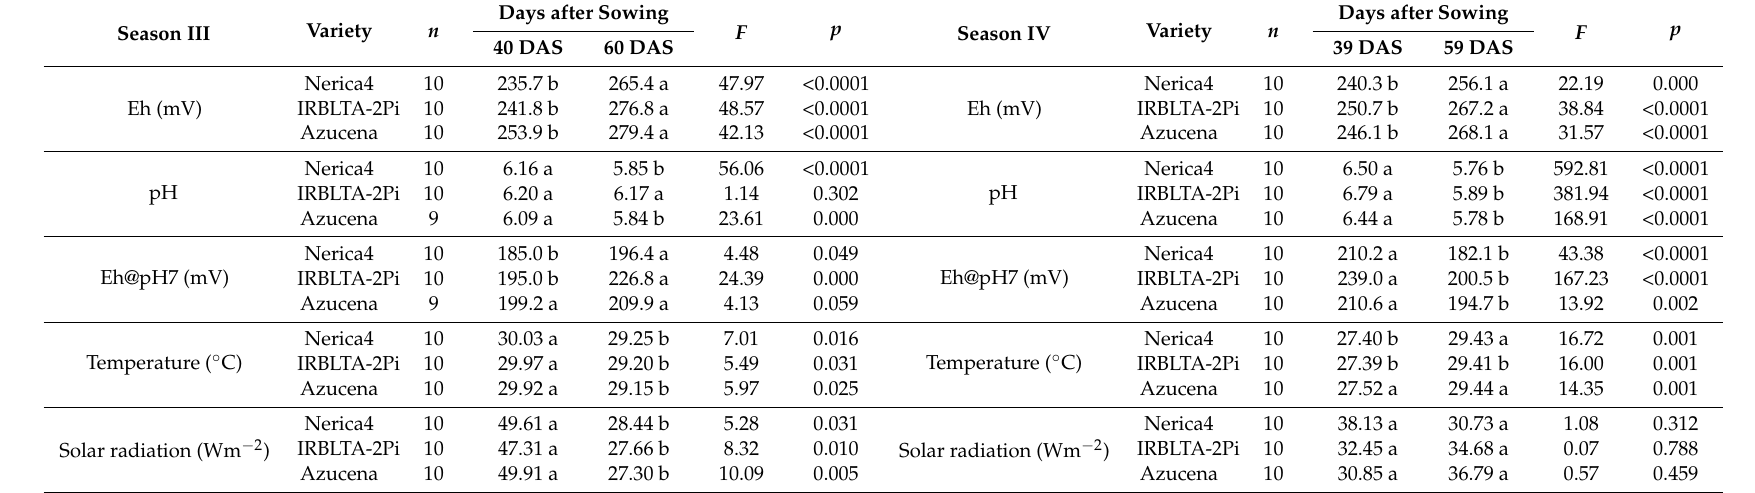
Table 2. Means and pairwise comparisons of Eh, pH, Eh@pH7, mean temperature and solar radiation intensity at two plant ages (39–40 and 60 DAS days after sowing) for three rice varieties (Nerica4, IRBLTA2Pi, Azucena) in two growing seasons/fertilization, in aerobic conditions. In season III plants were sown 12 August 2016 and fertilized with NPK. In season IV plants were sown 2 December 2016 and fertilized with Hoagland solution. Measurements were made on the middle part of the last fully expanded leaf of the main tiller. F and p values of the analysis of variance (ANOVA) are indicated. Values followed by different letters indicate significant difference between plant ages at 95% confidence interval Ryan-Einot-Gabriel-Welsh test Q (REGW- Q